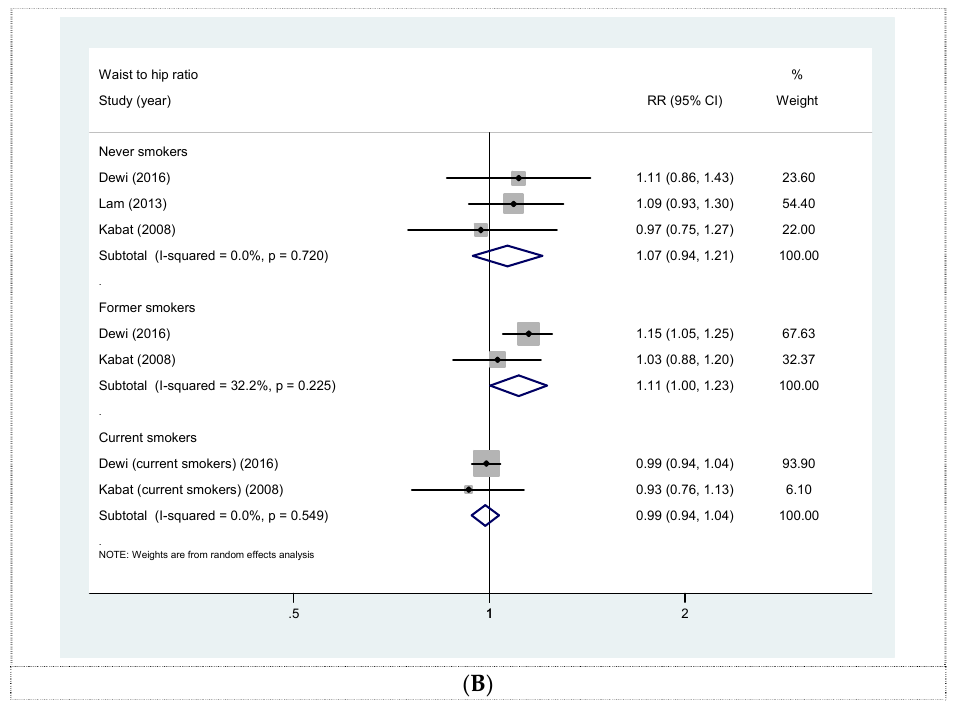
Figure 3. ( A ) Forest plot for linear dose ‐ response analysis on waist to hip ratio and lung cancer risk, per 0.1 unit increase; ( B ) forest plot for linear dose ‐ response analysis on waist to hip ratio and lung cancer risk stratified by smoking status. CI confidence interval; RR relative risk.